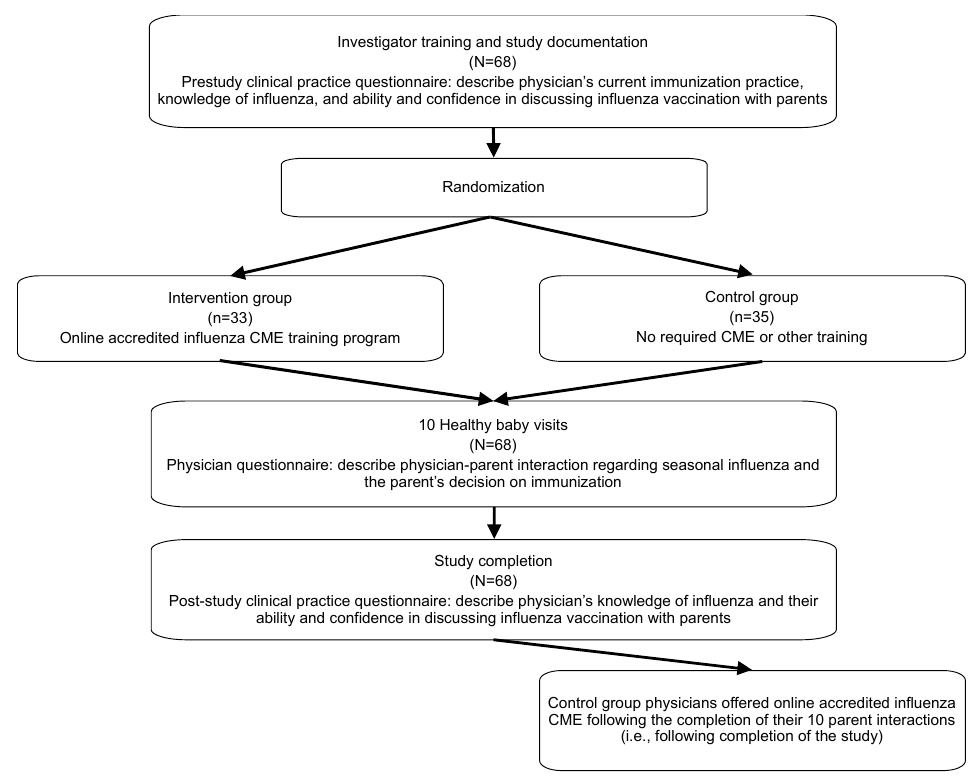
Figure 1. Flow chart of study enrolment and protocol.